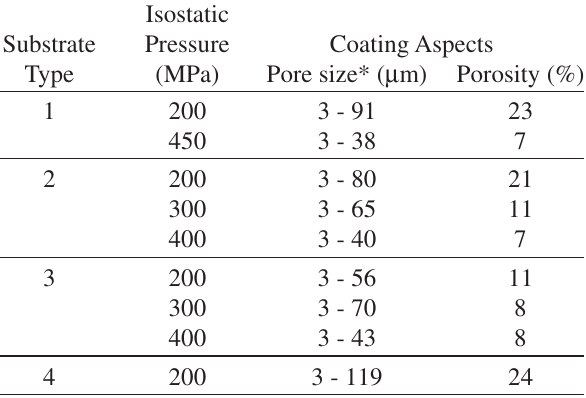
Table 2. Isostatic pressures used and coating properties for the different substrate